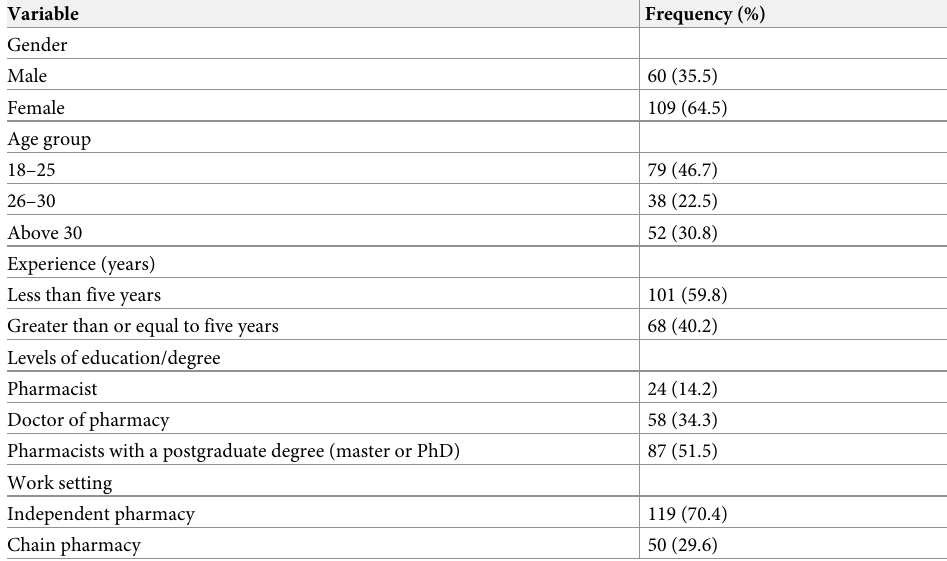
Table 1. Frequency distribution of sociodemographic characteristics of participants (n = 169).